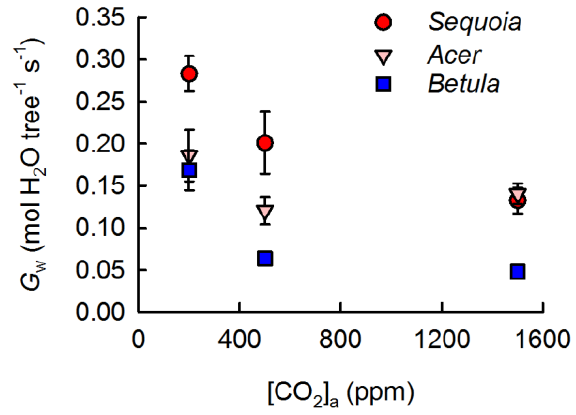
Fig. 6. [CO 2 ] a -regulated canopy conductance to water vapour. Whole canopy transpiration rates ( G w ) increase with declining Figure 6. [CO ] -regulated canopy conductance to water vapour. Whole canopy 2 a [CO 2 ] a . Values are means ± SEM. ( n = transpiration rates ( G ) increase with declining [CO w